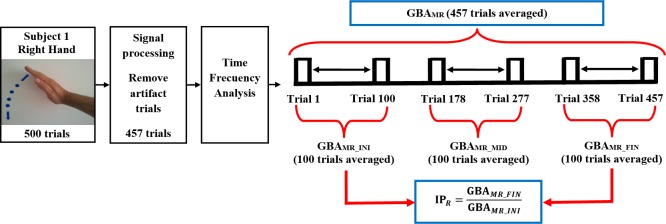
Example of the procedure used for the calculation of IPR (subject 1, right hand).In this example 457 of the 500 trials of the motor task were obtained free of artifact. The GBAMR value expressed as μV2 is obtained through the time-frequency analysis of the valid trials (457). For the calculation of the IPR, the average value of the last 100 valid trials is obtained (GBAMR_FIN) and it is divided by the average value of the first 100 valid trials (GBAMR_INI). The IP has no units. GBA = Gamma band activity, IP = Index of plasticity, MR = Motor Right, INI = Initial, MID = Middle, FIN = Final.